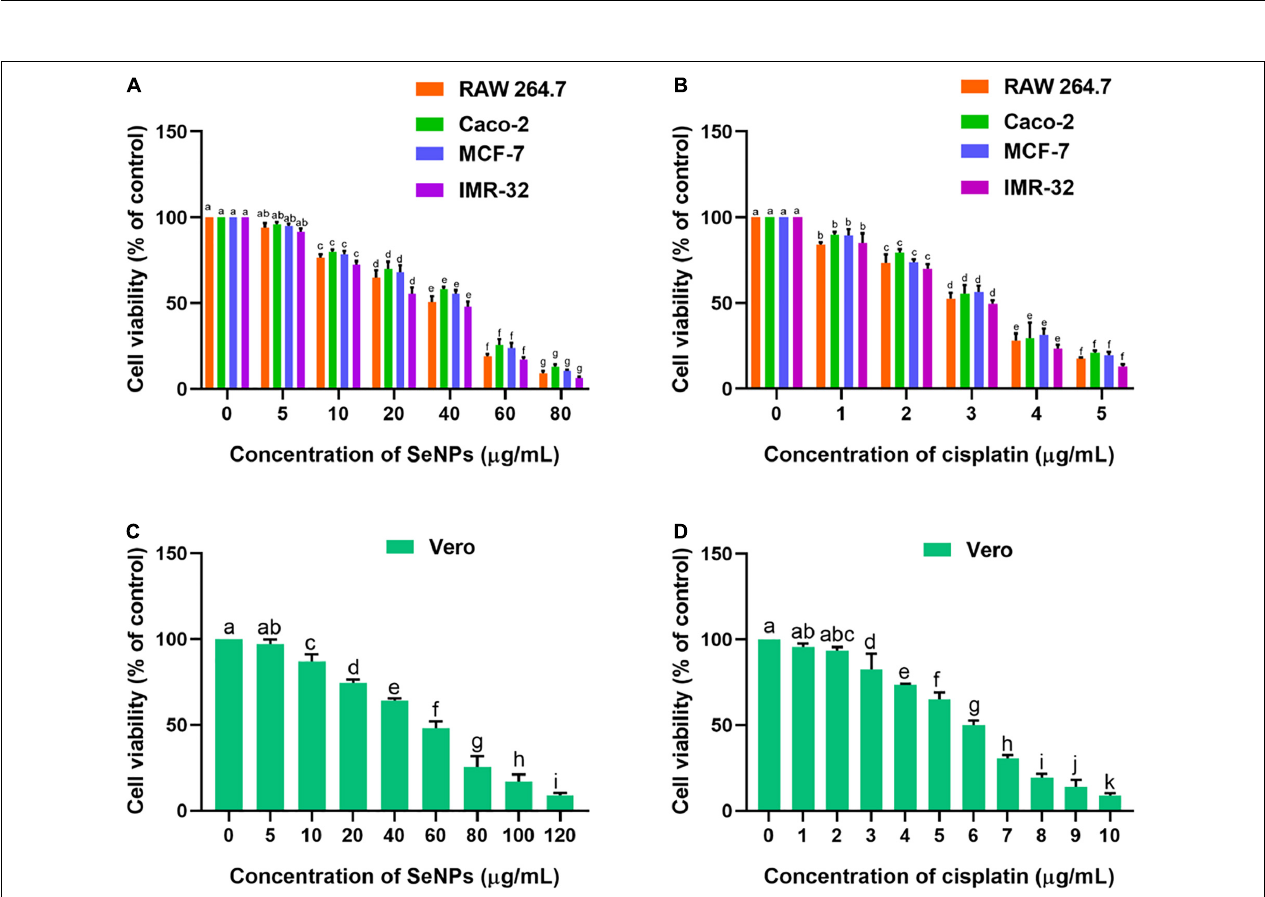
FIGURE 10 | (A) Dose-dependent effect of SeNPs on cell viability of cancer cells determined by MTT assay. (B) Dose-dependent effect of cisplatin on cell viability of cancer cells determined by MTT assay. (C) Dose-dependent effect of SeNPs on cell viability of normal cells determined by MTT assay. (D) Dose-dependent effect of cisplatin on cell viability of normal cells determined by MTT assay. The experiments in the study were carried out three times, each time independently. The mean and SD of the triplicate research were calculated using the results from each experiment. The bar graphs with different letters within the particular analysis were significant ( p -value ≤ 0.05) by Tukey’s